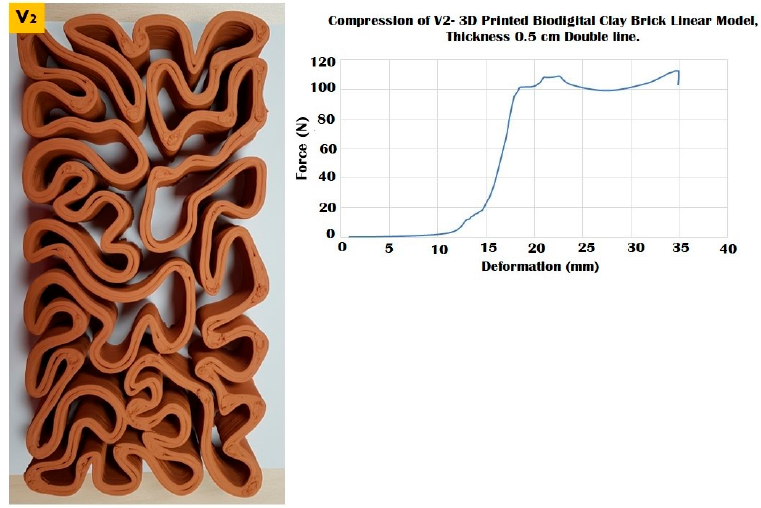
Figure 10. Exhibits the linear brick model of the V2 family of the biodigital clay bricks with double line linear thickness of 0.5 cm in the physical 3D-printed model ( left ). The graph exhibits the results of the compression test for the V2 linear model brick, showing the relation between force (N) ( Y -axis) and deformation (mm) ( X -axis). This model exhibited its maximum durability by resisting until 110 N before cracking and maintaining its resistance from 20 to 35 mm deformation under 100–120 N before collapsing at 110 N.